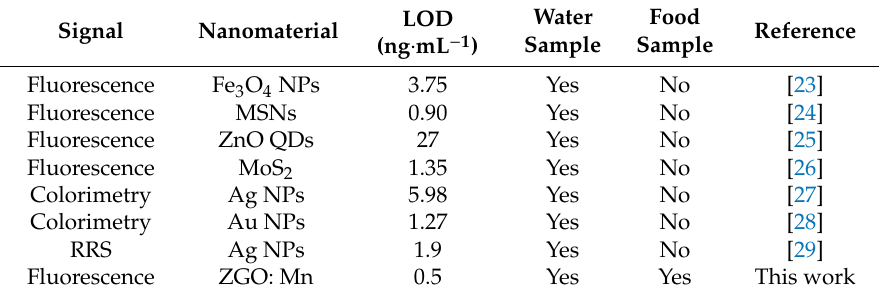
Table 1. Related reports on nanomaterial-based sensors for the detection of As(III). Signal